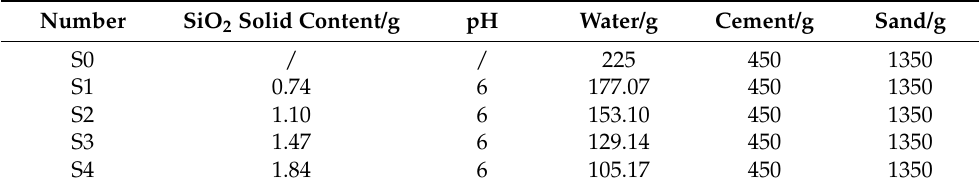
Table 7. Cement-based material ratio of precursor solution with different nano-SiO 2